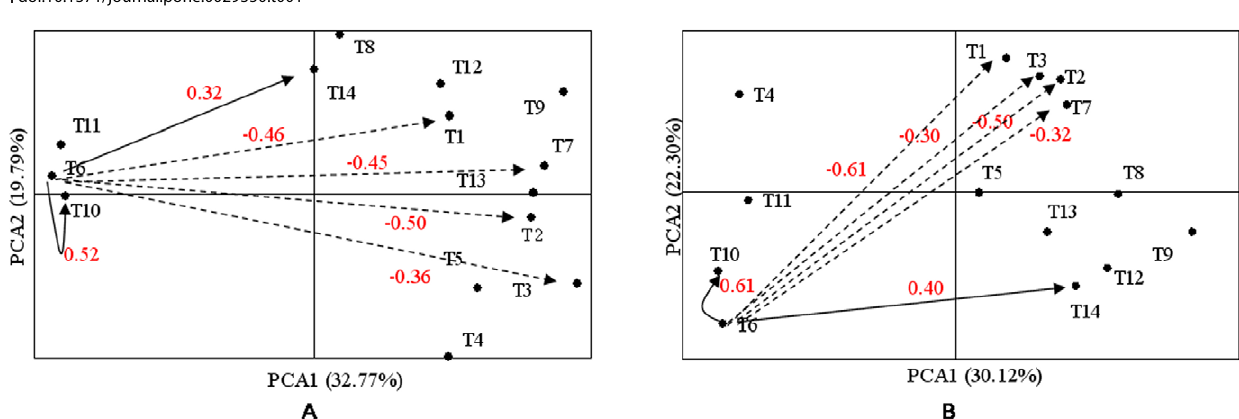
Figure 3. Relationship map constructed by PCA for 14 traits at A: Stuttgart, AR and B: Beaumont, TX. The distance between traits is inversely proportional to the size of the correlation coefficients. Solid and dashed lines indicate positive and negative correlations, respectively. Trait names are T1:Heading; T2:Plant height; T3:Plant weight; T4:Tillers; T5:Grain yield; T6:Harvest index; T7:Panicle length; T8:Panicle branches; T9:Kernels/ panicle; T10:Seed set; T11:1000 Seed weight; T12:Kernels/cm panicle; T13:Kernels/branch panicle; T14: weight/panicle. The variation explained by the principal components is showed in the brackets. doi:10.1371/journal.pone.0029350.g003 PLoS ONE |